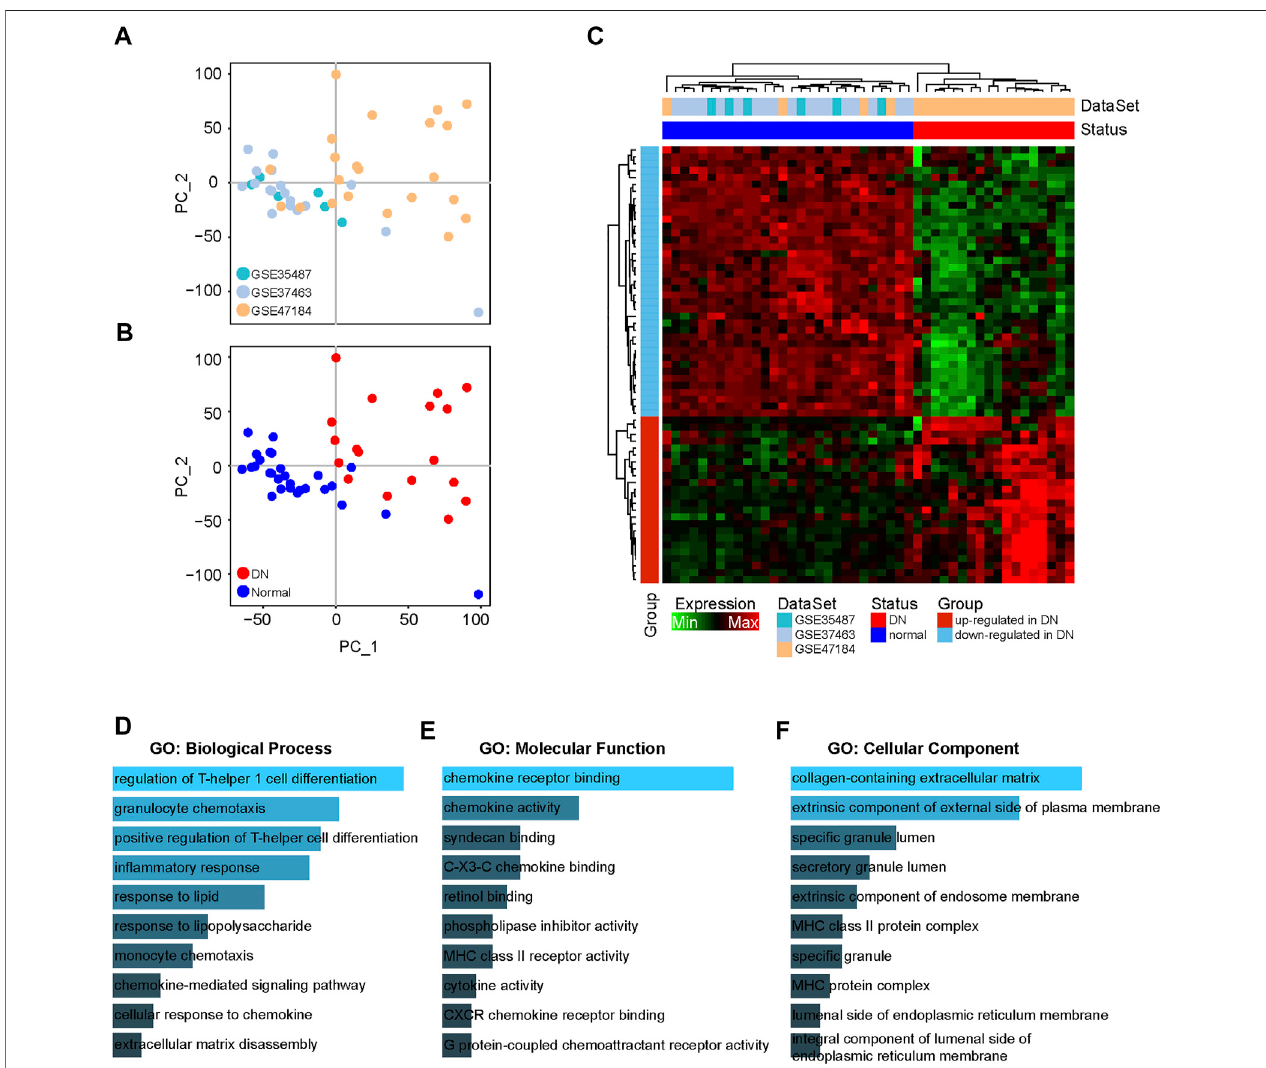
FIGURE1| Differentialexpression analysisofimmune-related genesbetween DNand healthysamples. (A) PCA fi gures displaying interbatch differences removed after integrating GSE35487, GSE37463 and GSE47184. (B) PCA fi gures displaying batch differences for the DN and healthy samples after integrating GSE35487, GSE37463 and GSE47184. (C) Heatmap showing the DEIGs between the DN and healthy samples. (D – F) GO analyses of DEIGs in terms of biological process, molecular function and cellular components.